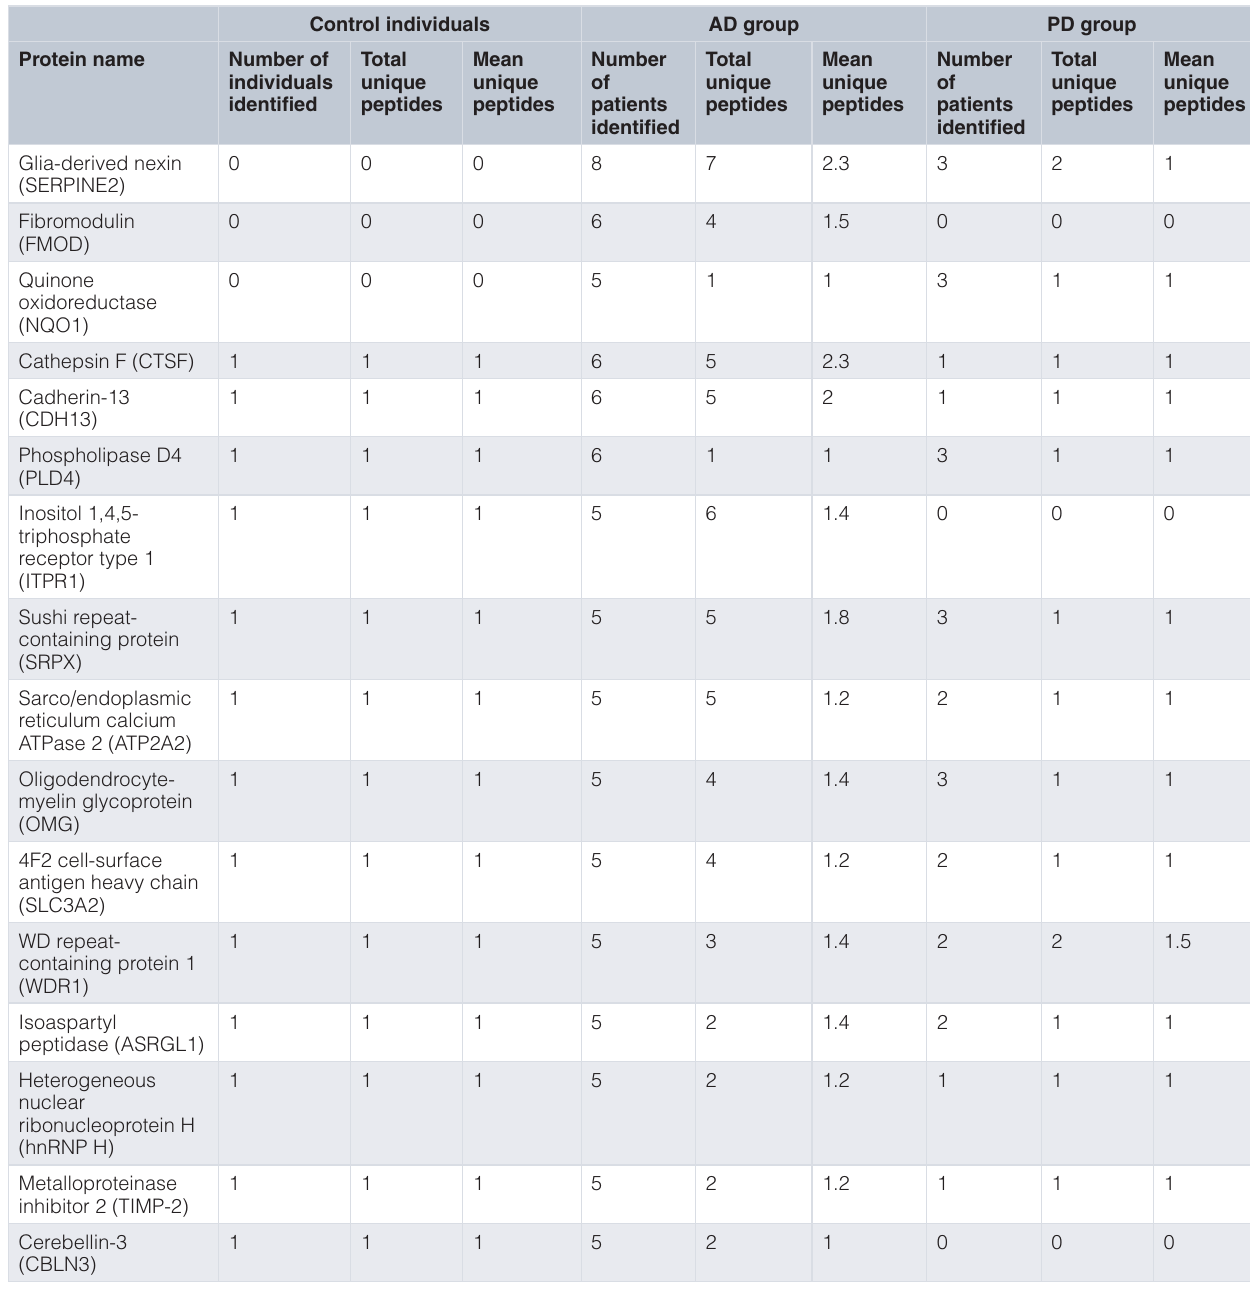
Table 2. Putative cerebrospinal fluid (CSF) autoantibody biomarkers of Alzheimer’s disease (AD), selected based on 1) identification in half or more of the patient group and 2) present in one or less individuals of the control